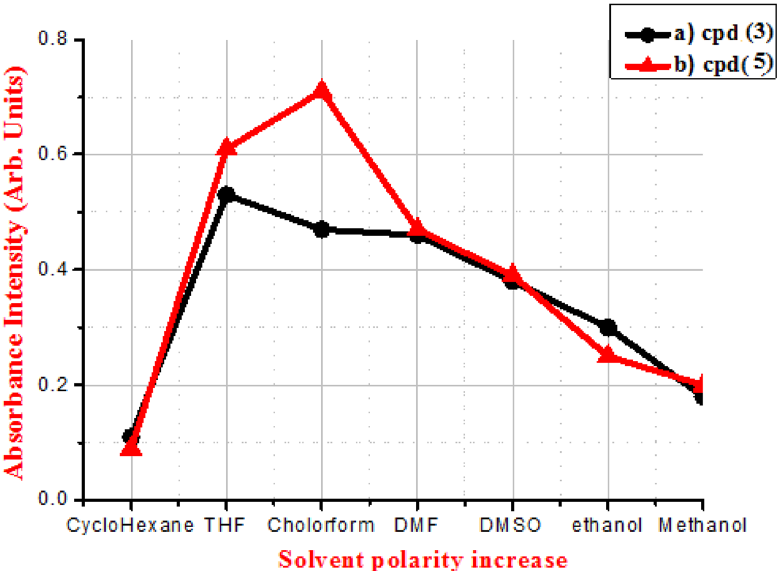
Figure 10. Absorption intensities of compounds 3 and 5 of concentration 1 × 10 −5 M in different solvent